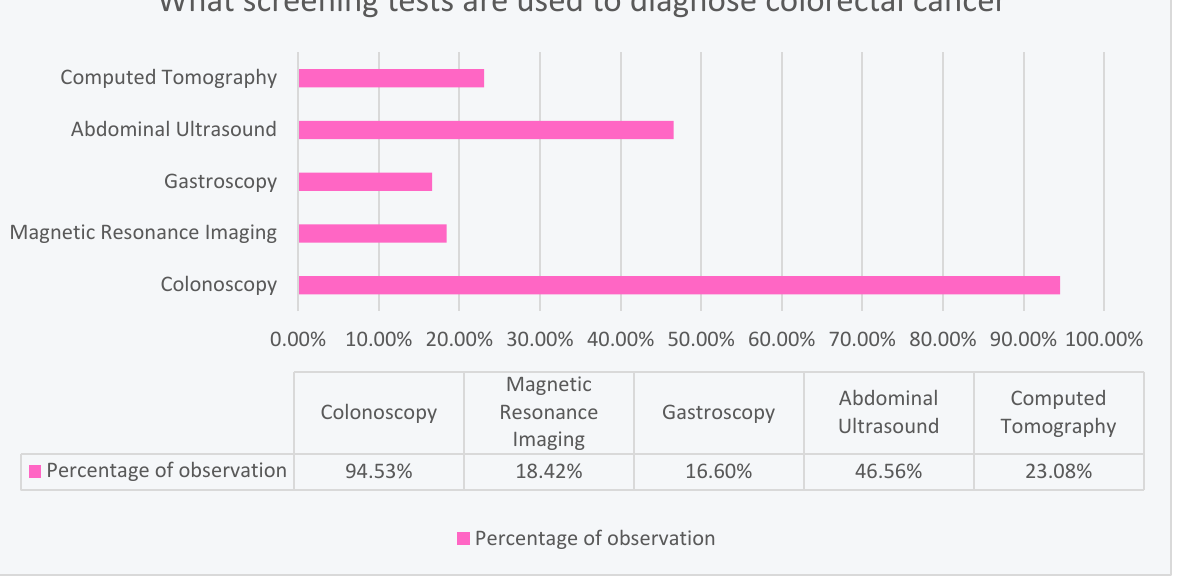
Figure 2. Colorectal cancer screening tests according to respondents’ knowledge.